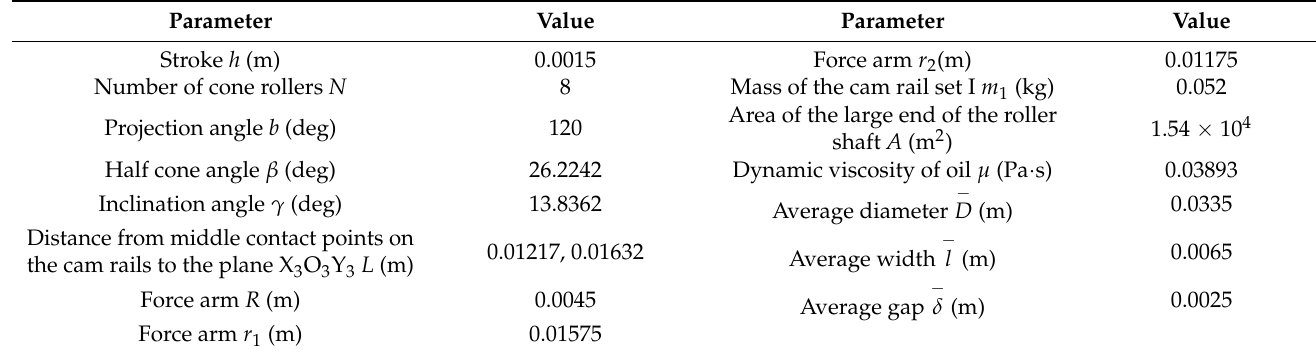
Table 1. Parameters for